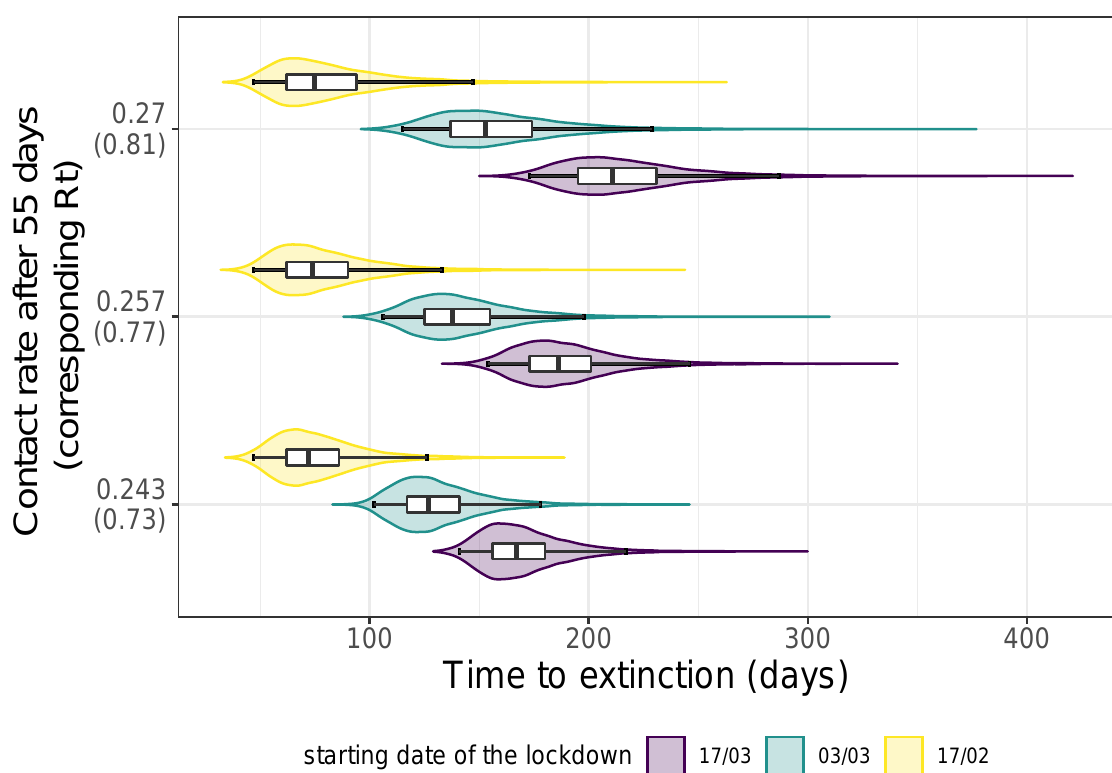
Figure 3 – Effect of the lockdown intensity, stochasticity, and initiation date on the time to extinction ( τ ) under individual spreading heterogeneity assumption. The distributions of the time to extinction (in days since the start of the lockdown) for several contact rate restrictions post 55 first days are plotted on the Y-axis using violin plots and